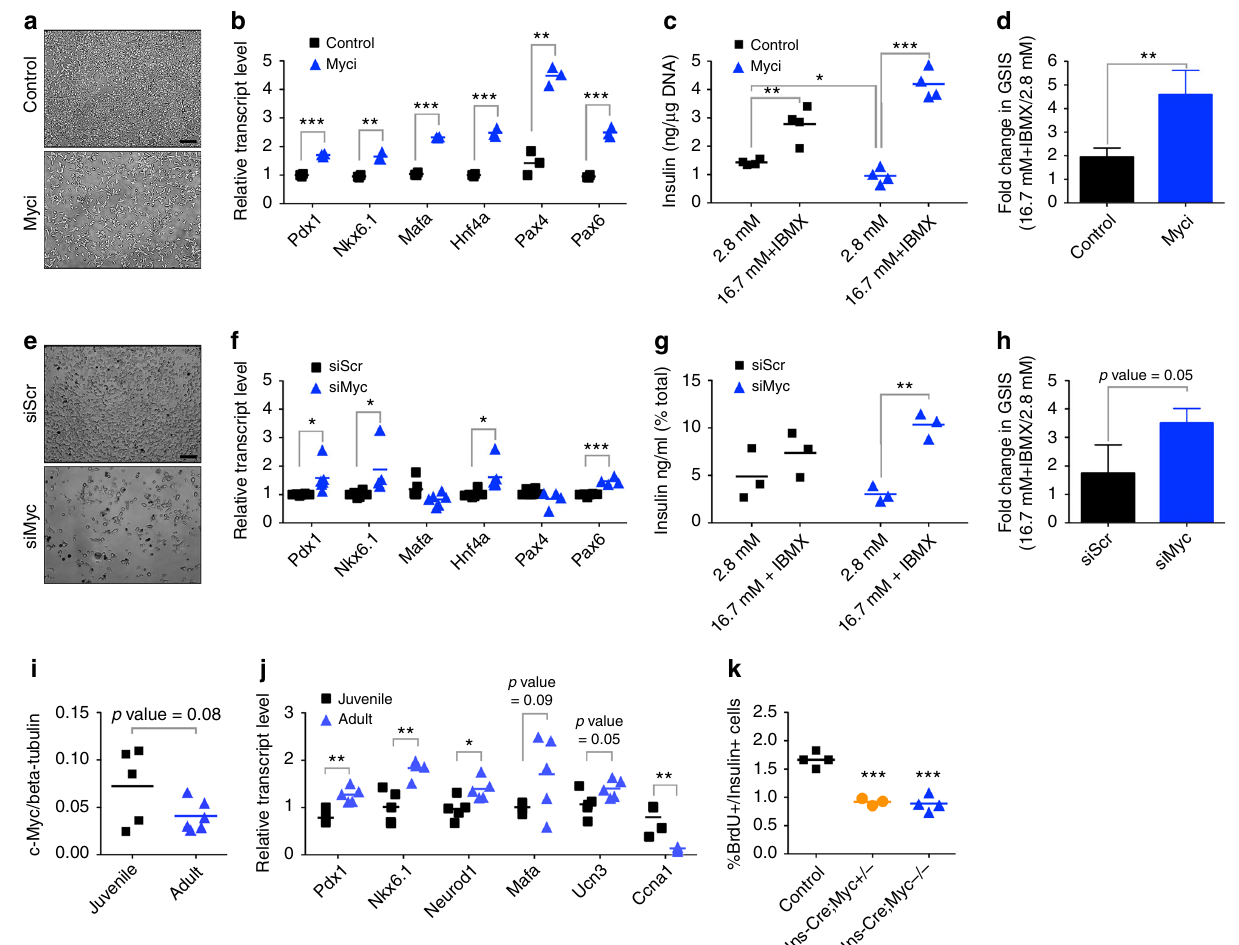
Fig. 1 c-Myc plays a role in β -cell proliferation and function. a Cell density of INS-1 cells upon Myc inhibition with 40 µ M Myci for 2 days as compared to control (DMSO) treatment. Scale bar, 100 μ m. b Quantitative PCR to detect gene expression of key β -cell regulatory transcription factors upon Myc inhibition (Myci, 40 µ M) after 2 days of inhibitor treatment, n = 3 per group. ** p < 0.005, *** p < 0.0005, Student ’ s t test. c Control (DMSO, n = 4)